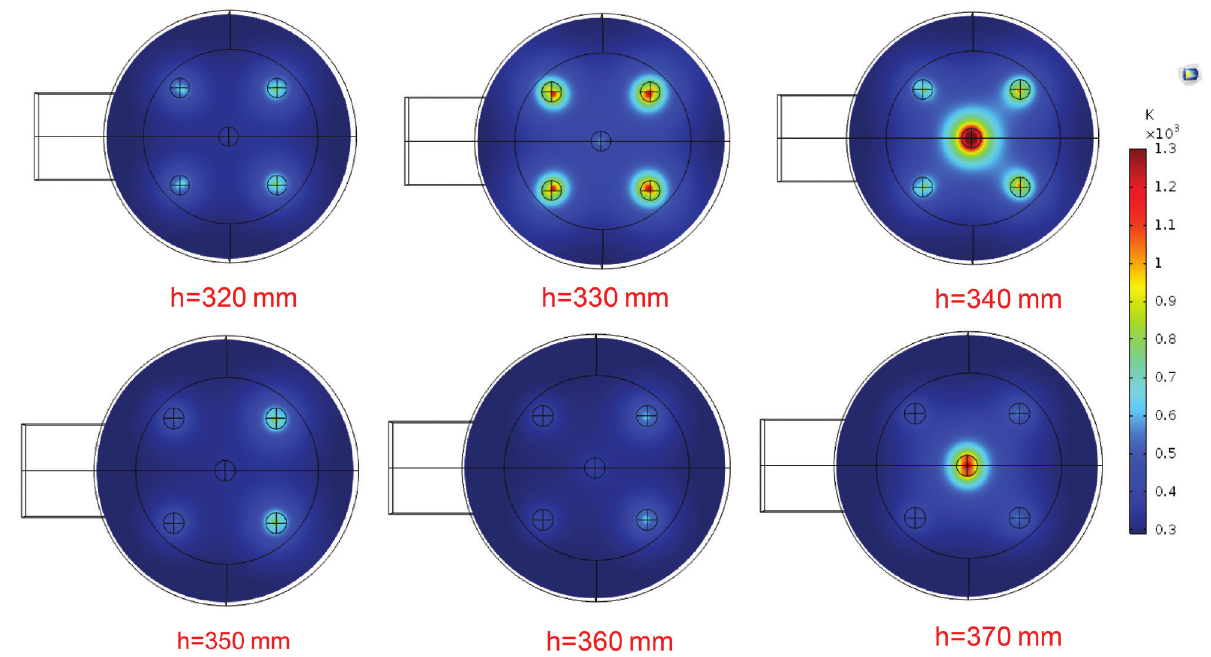
Figure 6: The temperature distribution profiles of combination B, height range from 320 to 370